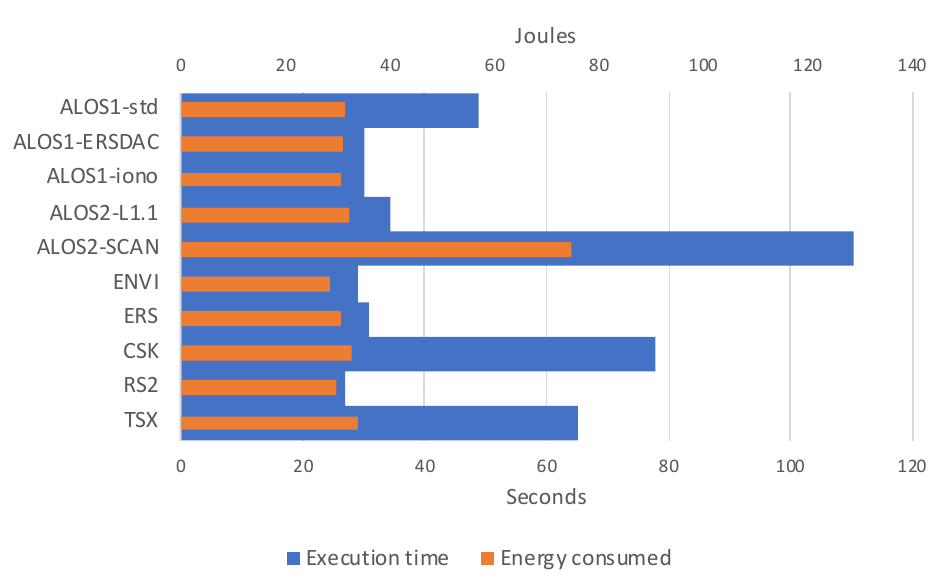
Figure 11. Graphical representation of the execution times for considered datasets on Jetson Nano hardware configuration set on 5-watt power mode, and relative joules of energy consumed.